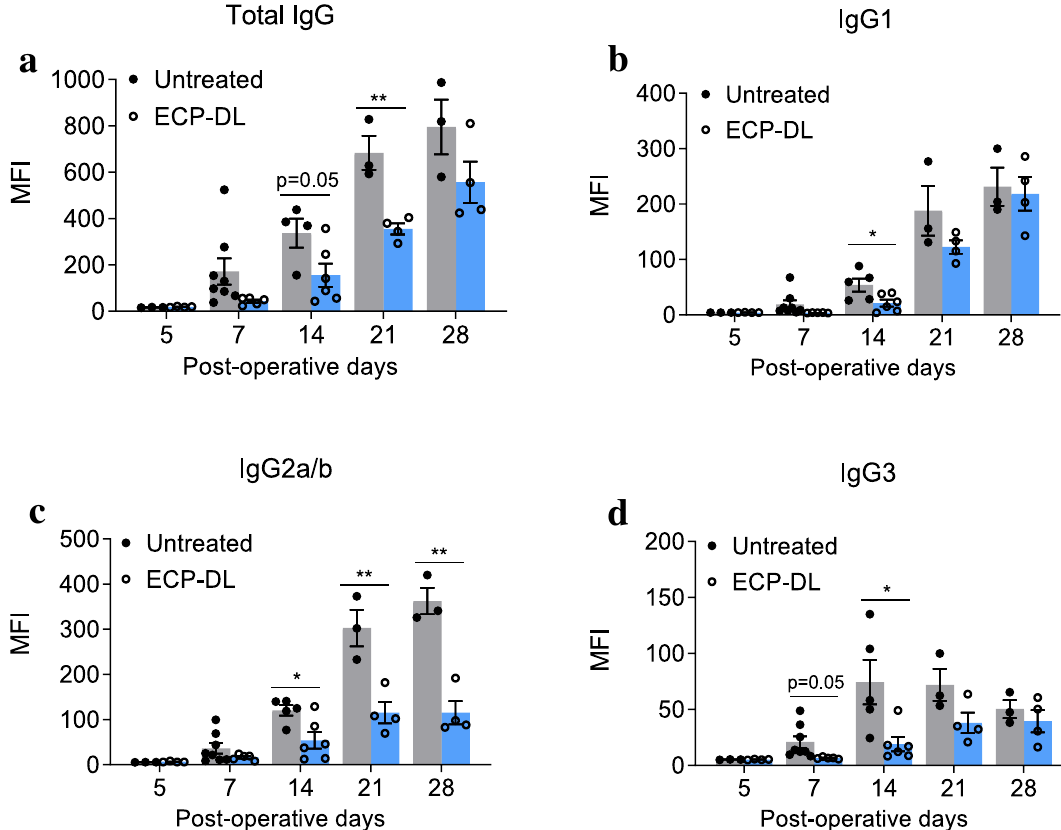
Figure 4. Treatment with ECP-DL inhibits the production of donor-specific antibodies (DSA) following heterotopic heart transplants. After heart transplantation (BALB/c to B6), plasma samples were collected from B6 recipient mice and assessed for DSA at POD5, 7, 14, 21, and 28 (n = 3–8 for each timepoint). Transplant recipients either received ECP-DL at day -7 or no treatment. Production of all DSA subtypes was lower in ECP-DL treated animals at all time points compared to control. Minimal DSA production in the ECP-DL group at POD5 suggests that the animals are not sensitized by ECP-DL infusion. MFI: Mean fluorescence intensity; * p < 0.05, ** p < 0.01 by two-way ANOVA, followed by classical